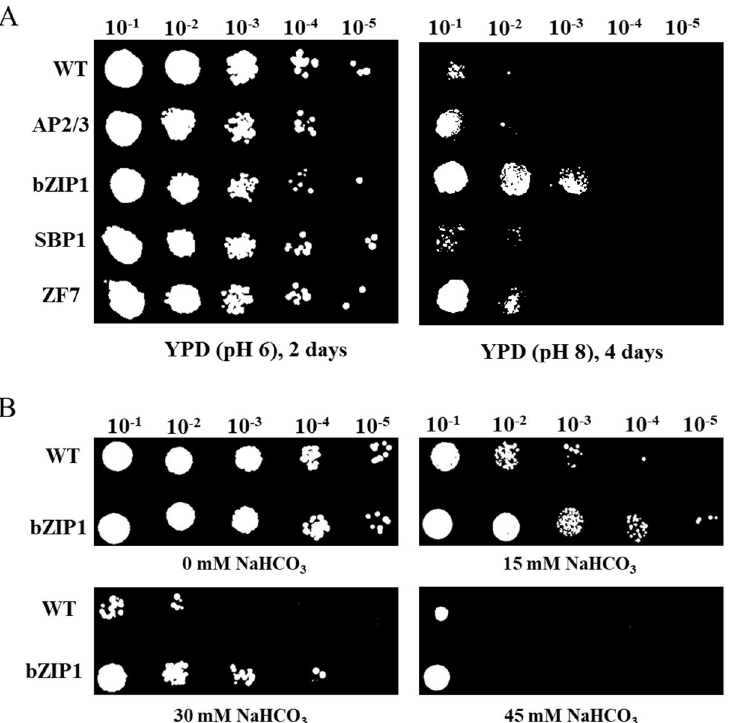
Figure 2. Transcription factor screening from Chlorella sp. BLD with alkali tolerance analysis in S. cerevisiae. ( A ) TFs (AP2/3, bZIP1, SBP1 and ZF7) were constructed to the pEGH-A vector and transformed into Y258 yeast. Serial dilutions were spotted onto pH 8 yeast YPD solid plates as alkali treatment, and on normal YPD (pH 6) solid plates as control. ( B ) Yeast cells with bZIP1 overexpression and WT were diluted and spotted onto the YPD solid medium supplemented with 0 mM, 15 mM, 30 mM, and 45 mM NaHCO 3 .